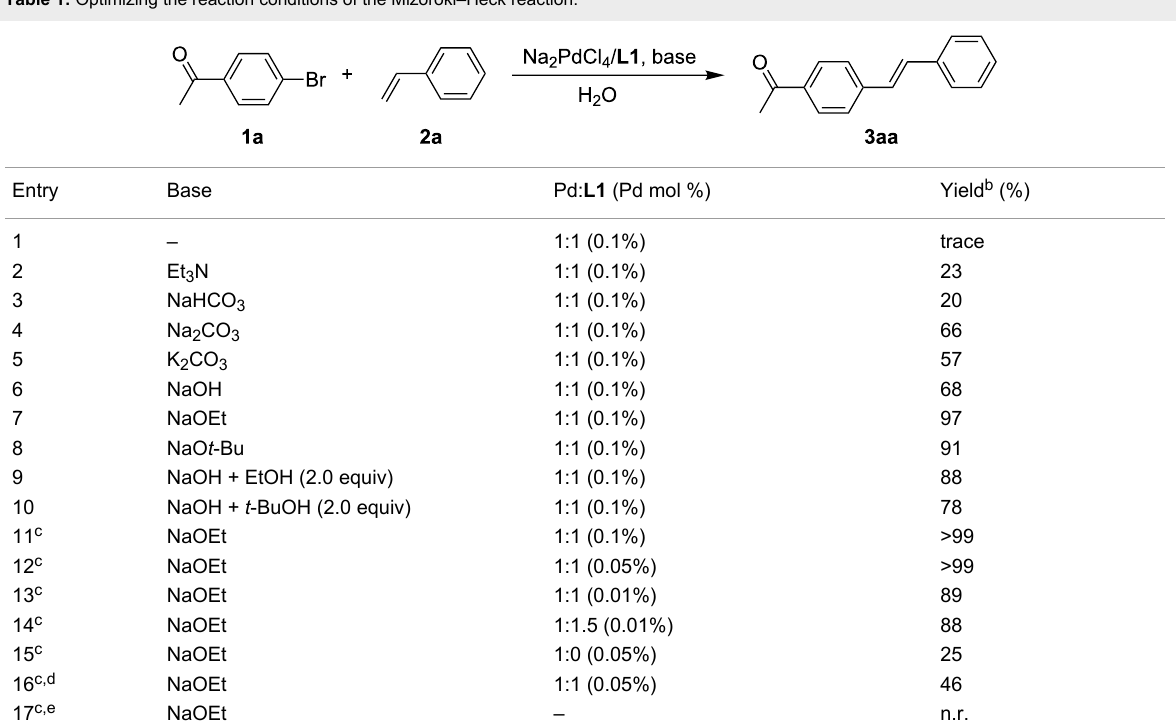
Table 1: Optimizing the reaction conditions of the Mizoroki–Heck reaction. a